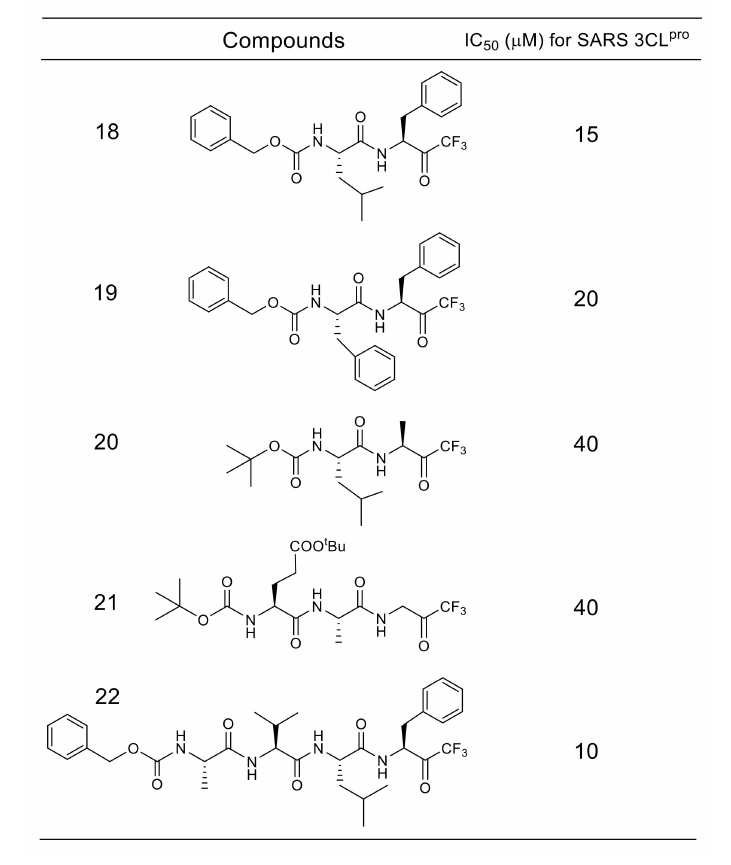
Inhibitory activity of substrate-based trifluoromethyl ketone compounds against SARS-CoV 3CL pro